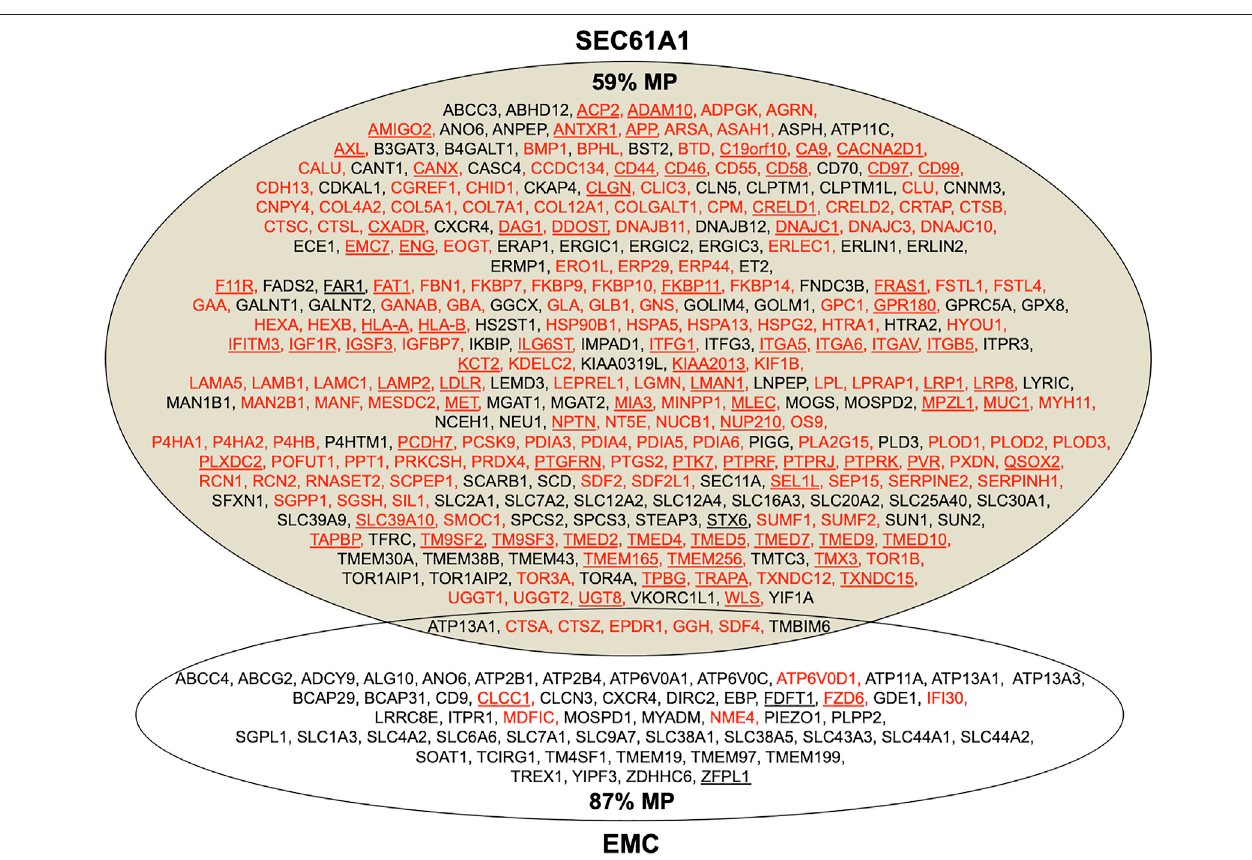
FIGURE 8 | Venn diagram for the Sec61 complex and ER membrane complex (EMC) in the human ER membrane and their clients. The diagram summarizes precursors with SP (in red) or TMH (in black), which are destined to the secretory pathway and were negatively affected by the indicated depletion; membrane protein precursors with SP are underlined, as are TMH proteins with TA. All these precursor polypeptides are de fi ned as potential clients or substrates of the respective componentorcomplex.ThesectionforSec61summarizesthenegativelyaffectedproteinsaftertheSec61depletioninHeLacells(Nguyenetal.,2018);thesection for EMC summarizes the negatively affected proteins after the EMC knock-out in HeLa cells (Shurtleff et al., 2018; Tian et al., 2019). The percentage of membrane proteins (MP) of the secretory pathway among the respective clients is indicated (%).